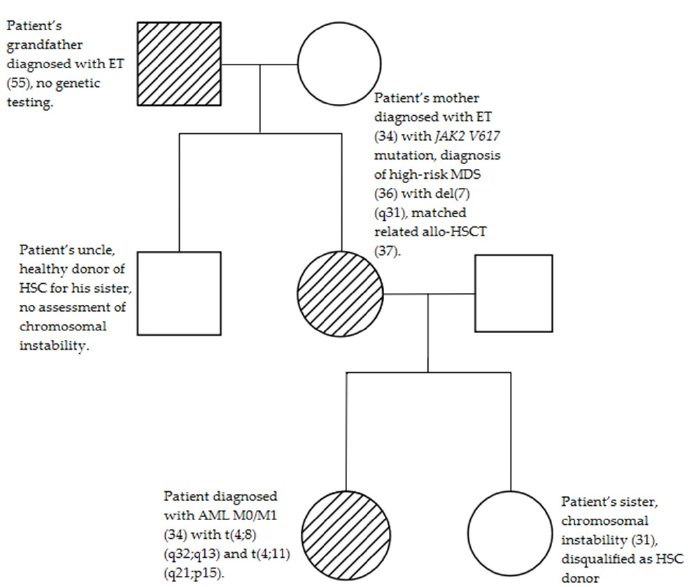
Figure 2. The pedigree of the patient’s family. The numbers in parentheses represent the age of onset of the disease.